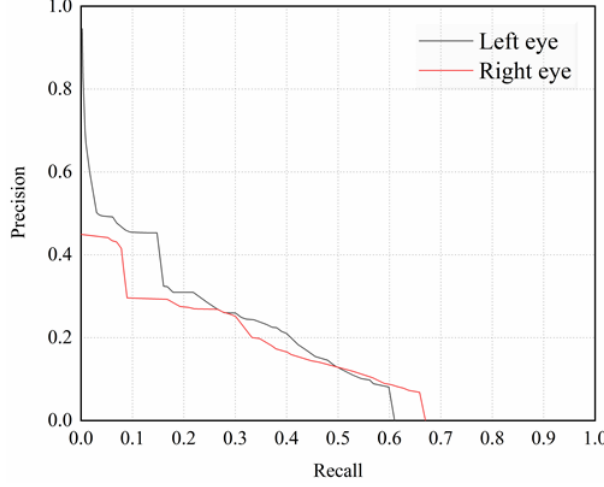
Figure 11. Precision – recall curves of the left and right eyes of the Faster-RCNN model. Table 1. Numerical results of evaluation metrics for YOLOV3 and Faster-RCNN eye detection mod-